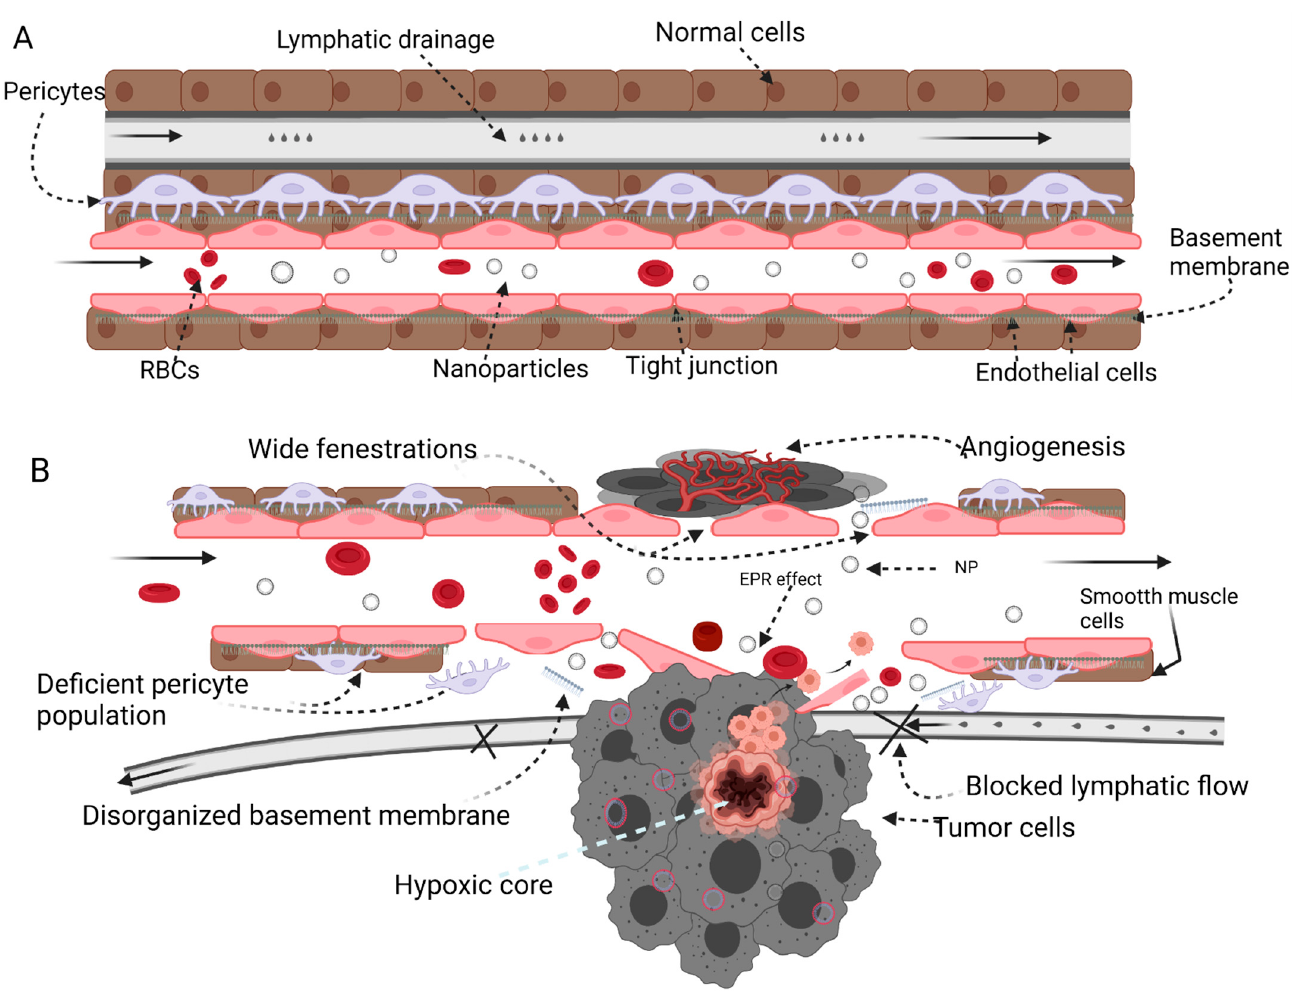
Figure 1. Comparison of the microenvironment of ( A ) healthy and ( B ) tumor tissues. The tumor microenvironment shows the disorganized components (hypoxic core, blocked lymphatic drainage, deficient pericyte population, disorganized basement membrane and wide fenestration) that are exploited for enhancing EPR effect. Created with BioRender.com. Accessed 25 July 2021.